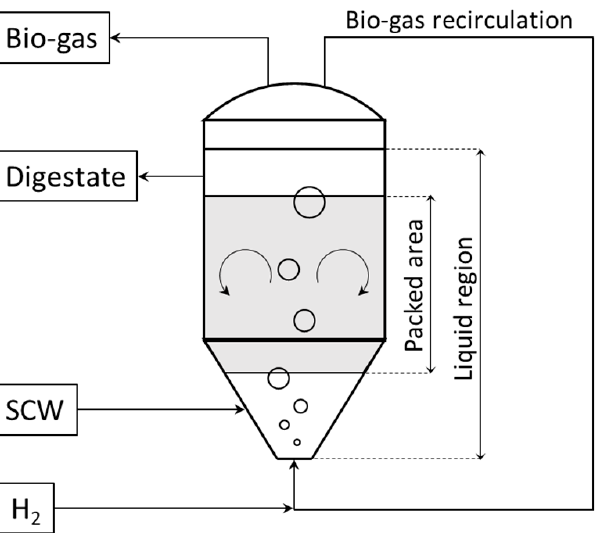
Figure 1. Schematic representation of the randomly packed gas stirred tank reactor. (GSTR).